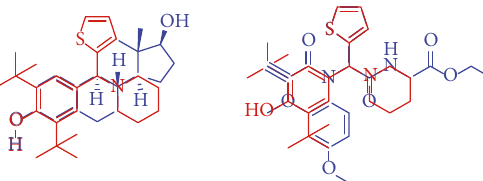
Figure 5: Superimposition of new 4-methyl substituted 2,6-di-tert- butylphenol derivatives and known